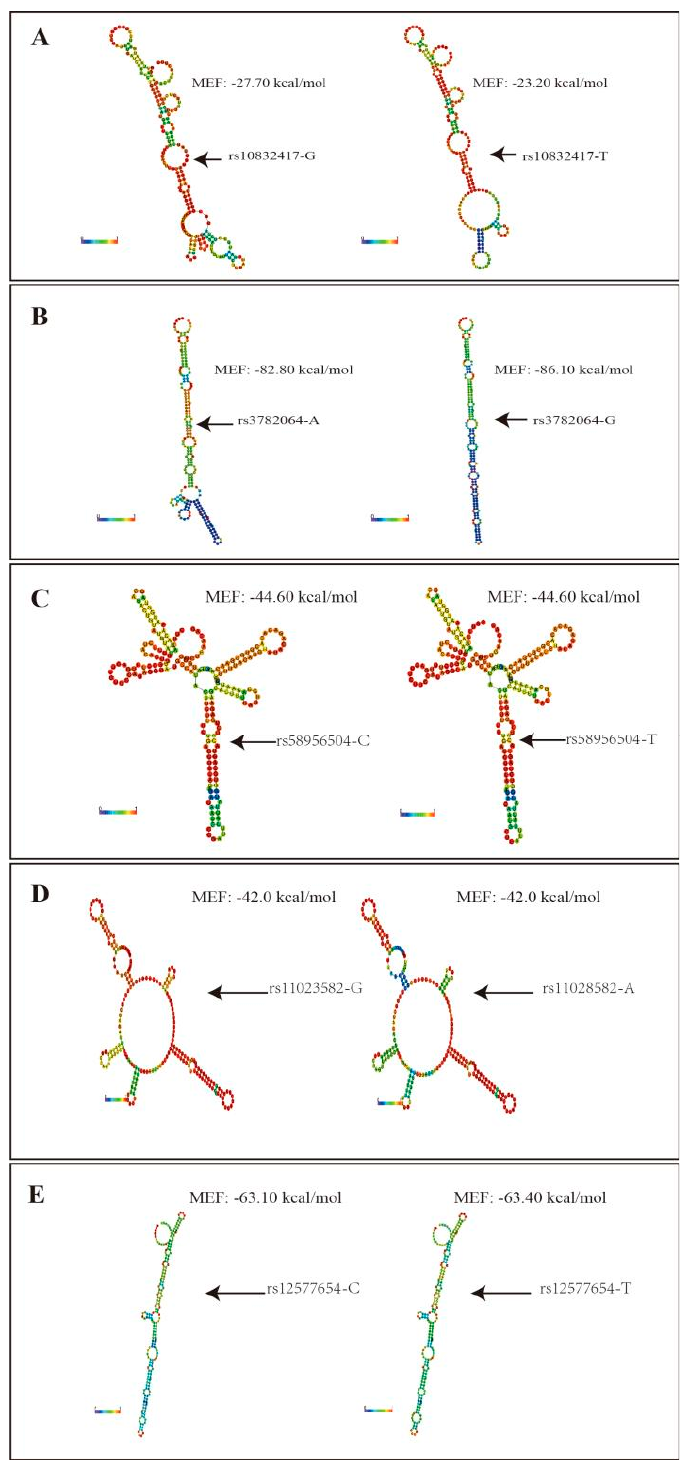
Figure 4. Minimum Free Energy (MFE) structure of the KCNQ1OT1. We used RNAfold. The predicted folding structures and MFE with ( A ) rs10832417 g or rs10832417-T; ( B ) rs3782064-A or rs3782064-G; ( C ) rs58956504-C or rs58956504-T; ( D ) rs11023582-A or rs11023582-G; ( E ) rs12577654-C or rs12577654-T. The structure is colored by base-pairing probabilities. For unpaired regions the color denotes the probability of being Table 1. The potential impact of each KCNQ1OT1-SNP on the establishment or destruction of the miRNA-binding site.